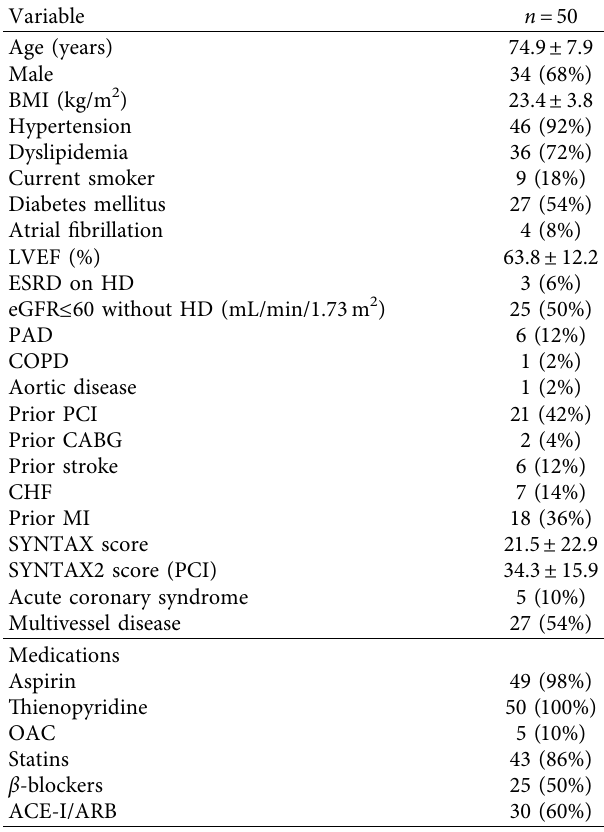
Figure 1: Crack formation pattern of calcified plaque. (a) Type 0, no cracks or injury in the vessel. (b, c) Type 1, with crack in calcified plaque (yellow arrowhead) or intima injury (red arrowhead) without medial dissection between calcified plaque and vessel wall. (d) Type 2, with crack in calcified plaque with medial dissection between calcified plaque and vessel wall (blue arrowhead). Table 1: Baseline clinical